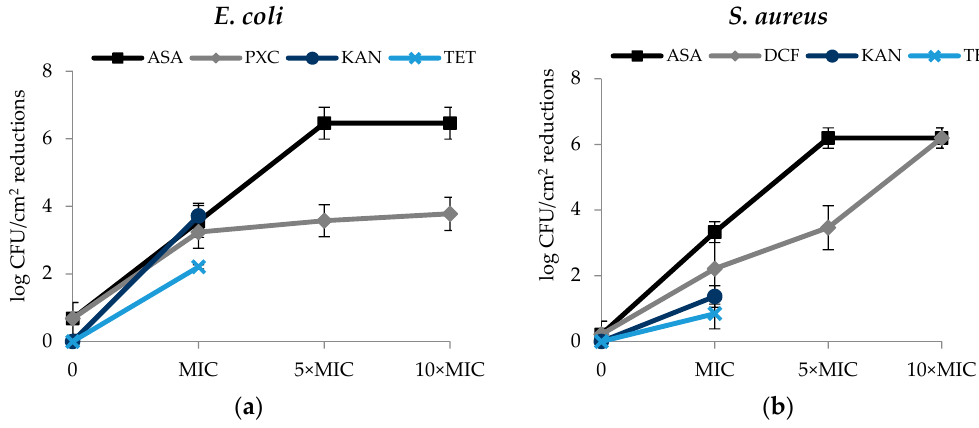
Figure 4. Effect of PXC (piroxicam), DCF (diclofenac sodium), ASA (acetylsalicylic acid), at three different concentrations (MIC, 5× MIC and 10× MIC) and KAN (kanamycin) and TET (tetracycline) at MIC (in this case, 5× MIC and 10× MIC were not tested) in the biofilm culturable cells—log CFU/cm 2 reduction. ( a ) E. coli and ( b ) S. aureus , after 24 h exposure. Mean values ± SD of three independent experiments are illustrated.